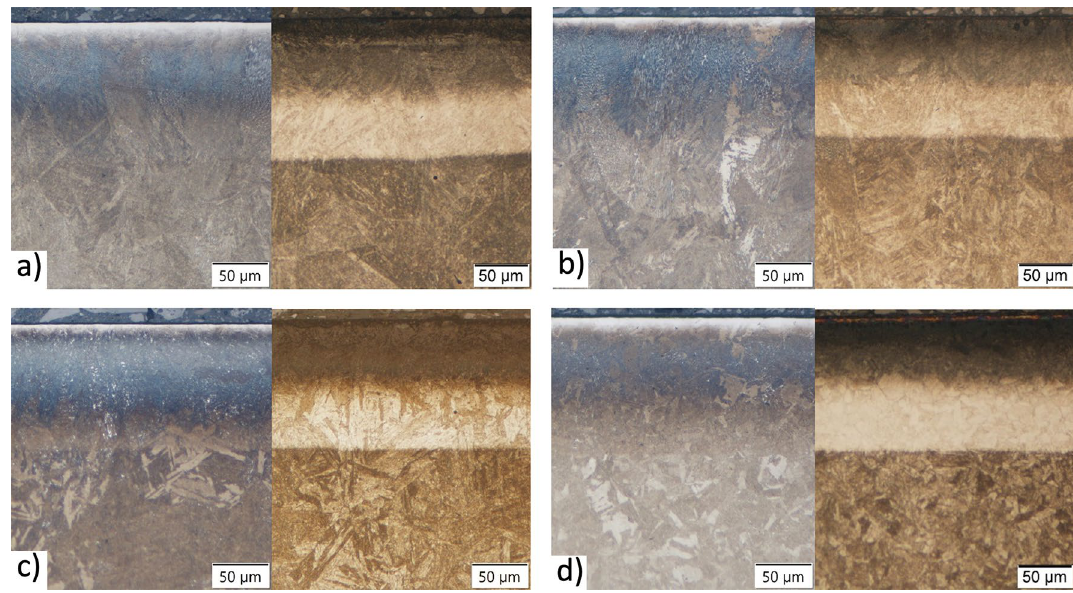
Figure 1. Light micrographs of a nitride layer etched by Nital (left part of the images) and ferric chloride (right part of the images) for maraging samples: ( a ) AM + N, ( b ) AM + DAT + N, ( c ) AM + SAT + N, ( d ) CM + SAT + N.